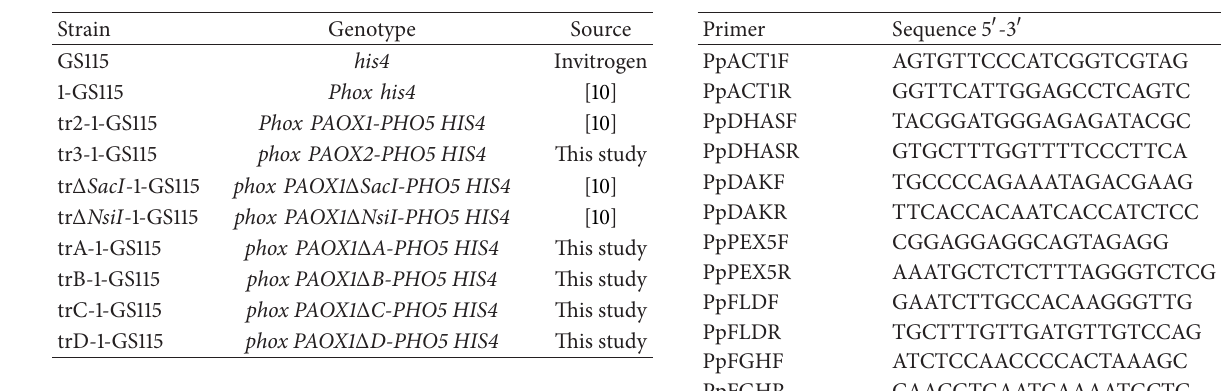
Table 2: Oligonucleotides used in this